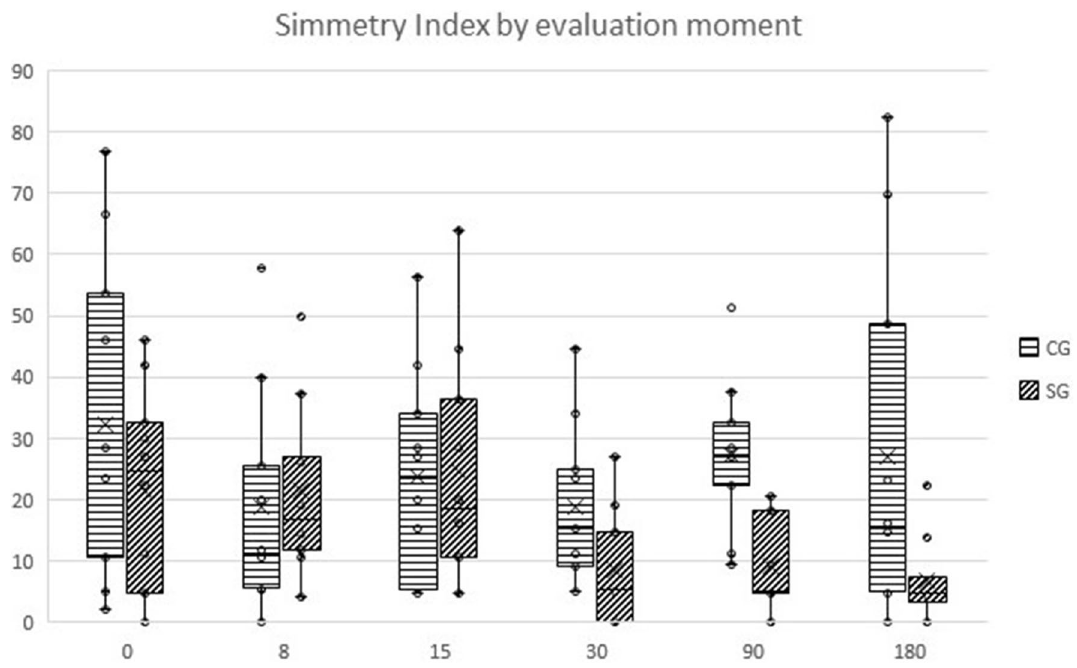
Figure 1. Overall evolution of Symmetry Index in the control group and treatment group. Box plots represent the median, 25th and 75th percentiles, and whiskers represent 10th and 90th percentiles.